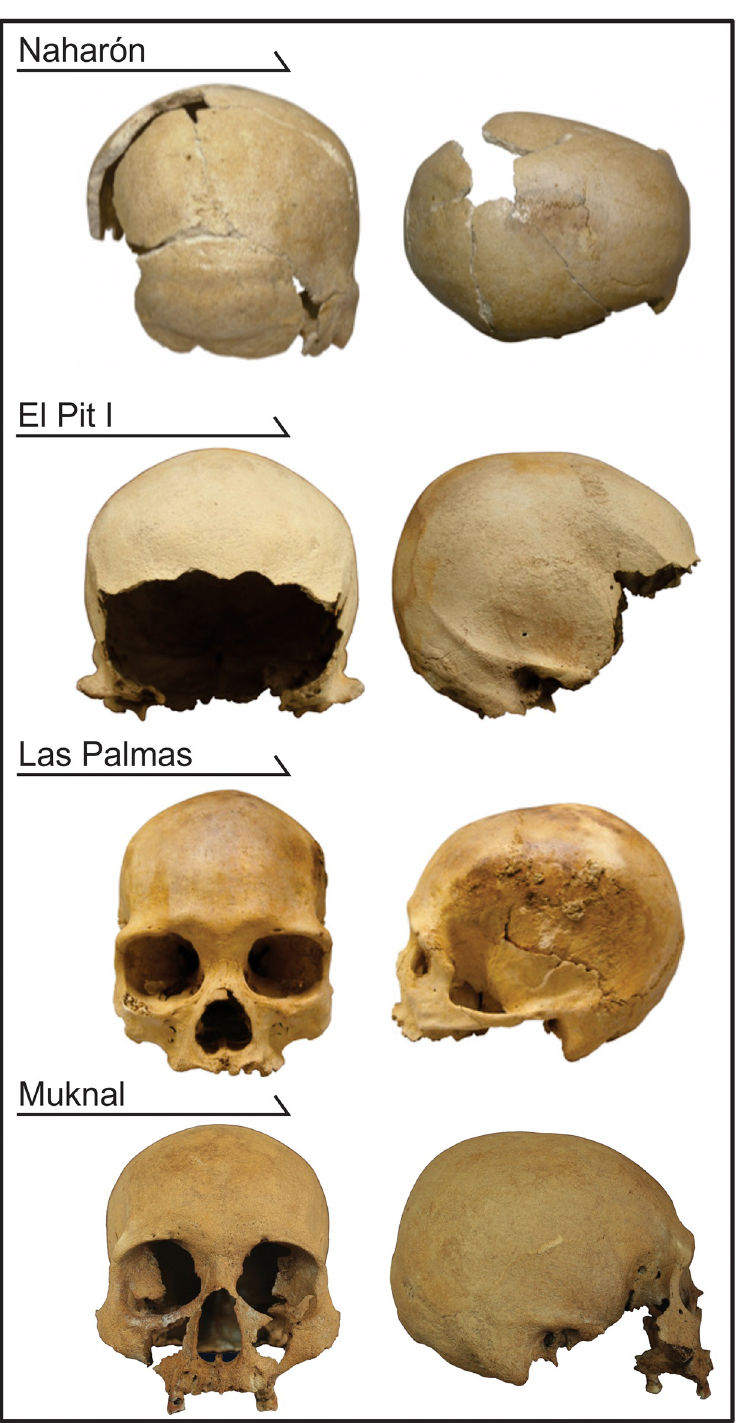
Fig 2. The early Quintana Roo specimens analyzed in this